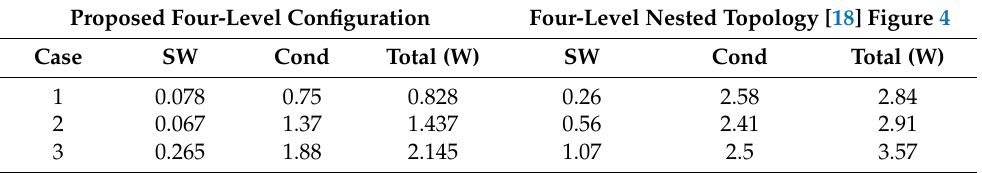
Table 3. Comparison of losses for newly proposed topology and nested topology for the four-level Comparison of losses for newly proposed topology and nested topology for the configuration . four-level